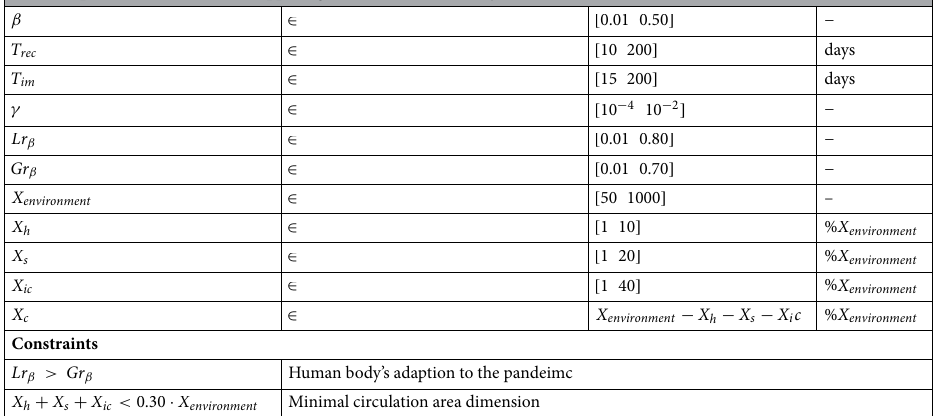
Table 1. Sensitive parameters threshold and constraints of the optimization